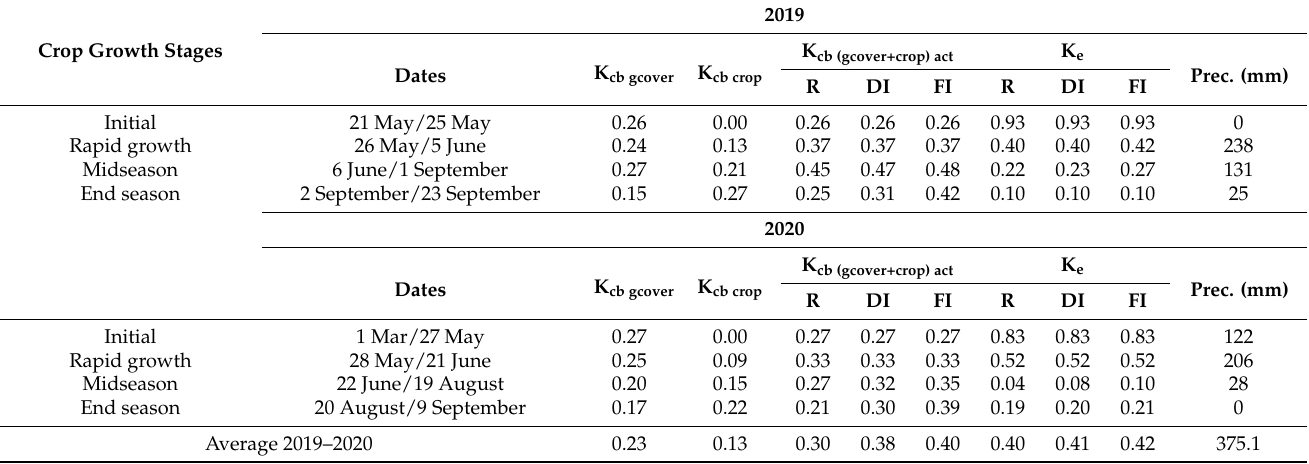
K cbgcover = basal crop coefficient of ground cover, K cbcrop = basal crop coefficient of vineyard, K cb(gcover+crop)act = actual basal crop coefficient,